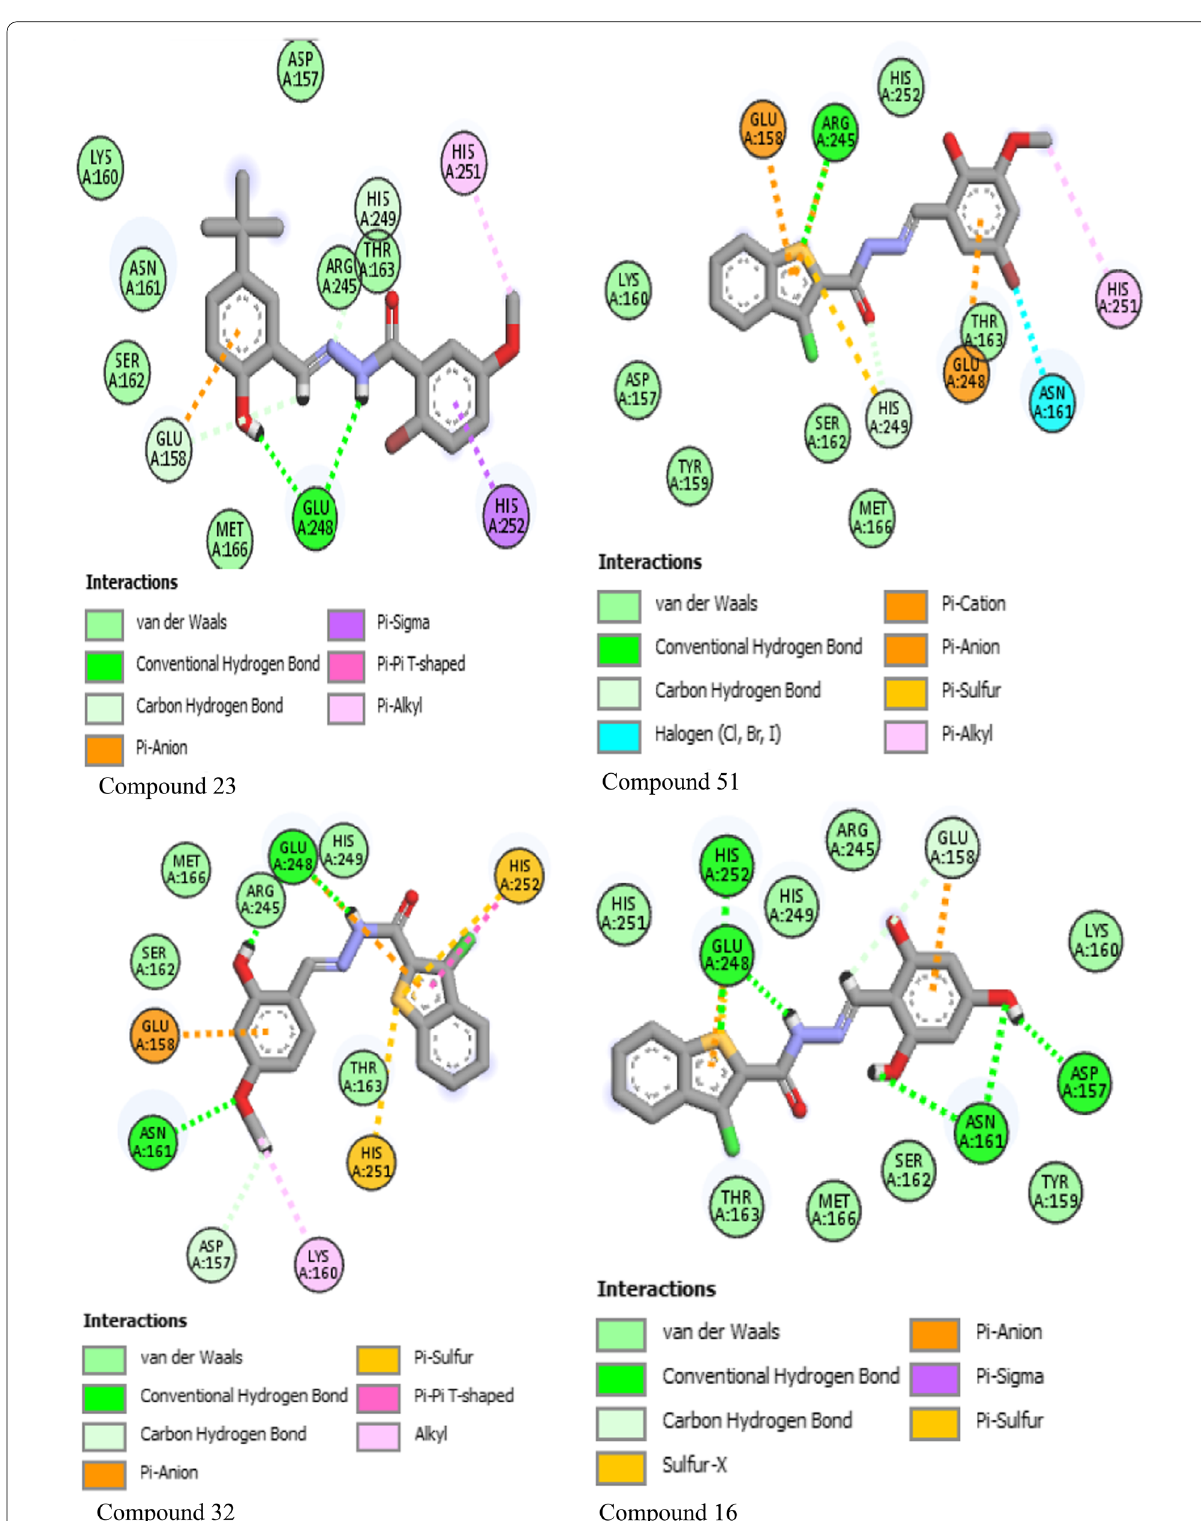
Fig. 4 2D diagram of ligands and the crystal structure of IncA soluble domain